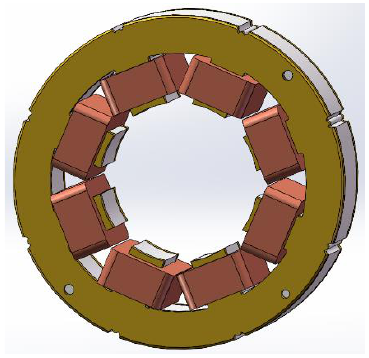
Figure 1. Three-dimensional model of an AMB stator.